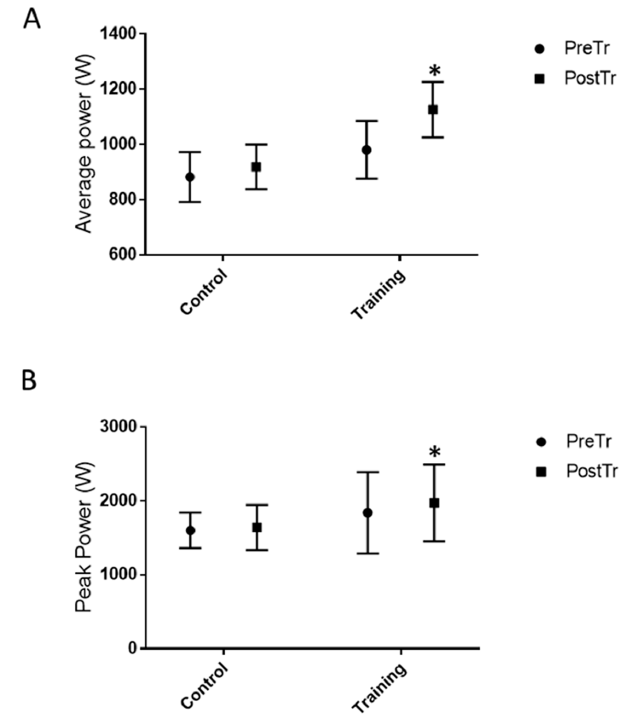
Figure 3. Functional test measures: ( A ) average power (W) and ( B ) peak power (W) before and after 8 weeks of plyometric jump training or rest. Peak values represent the highest of the three test jumps. * p < 0.005.